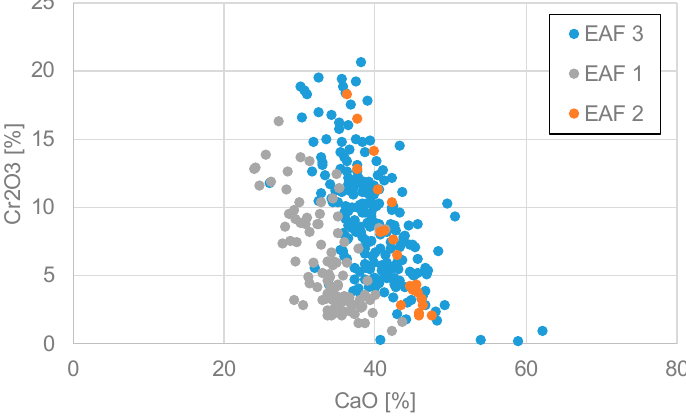
Figure 1. Variation of the Cr 2 O 3 concentration in stainless steel slags with CaO content at tapping.